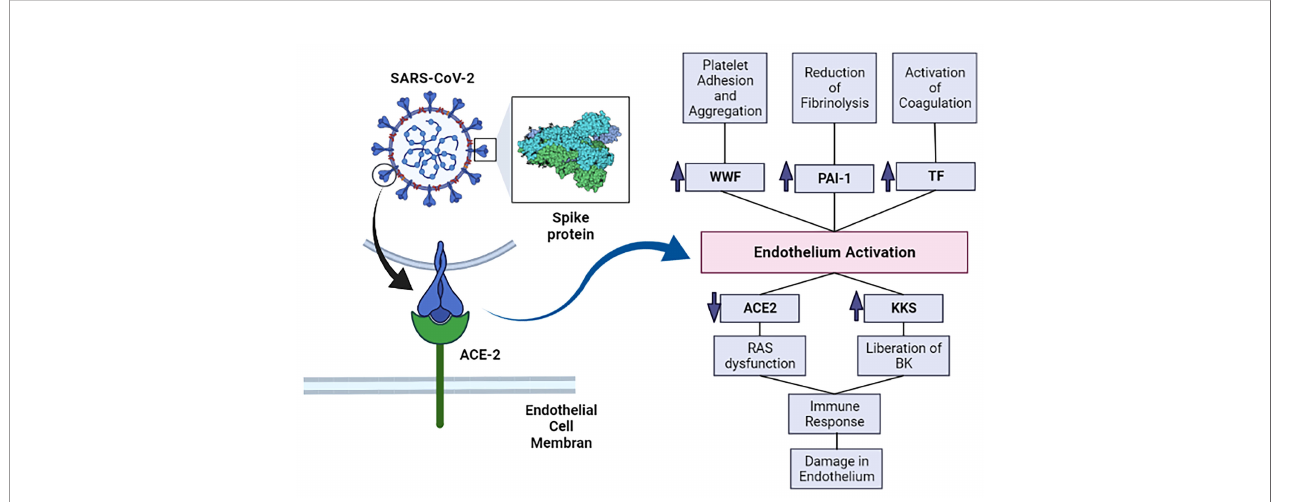
FIGURE 1 | The SARS-CoV-2 ’ s spike protein interacts with ACE-2 and allows SARS-CoV-2 infection. This infection causes activation of the endothelium and, subsequently, increases prothrombotic factors. The infection also enhances in fl ammation, which further damages the endothelium. ACE-2, angiotensin converting enzyme 2; KKS, Kallikrein-kinin system; RAS, renin-angiotensin system; BK, bradykinin; vWF, von Willebrand factor; PAI-1, plasminogen activator inhibitor – 1; TF, Tissue factor. Image created in: